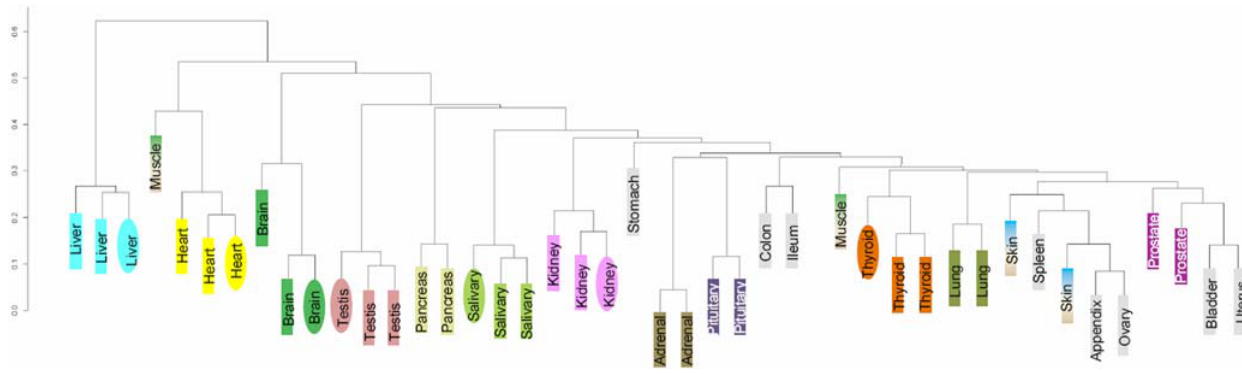
Figure 3. Distinguishing normal non-hematopoietic tissues. Despite differing platforms and experimental conditions, GE profiles can separate out normal tissues based on cell/tissue of origin. Dendrogram based on unsupervised hierarchical clustering, using (1 - Pearson correlation coefficient) as the distance measure. Rectangles indicate samples from the U133 A/B platform and ovals from the U133 Plus 2.0 platform. Triplicate sets of samples from human liver, heart, testis, kidney, etc. are from different studies, and their grouping together is a strong indicator of